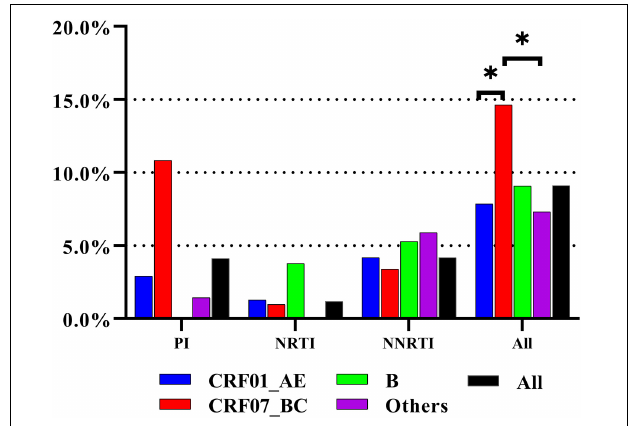
FIGURE 1 | The prevalence of TDR to three class of antiretroviral drugs in different subtypes. The prevalence of TDR was highest in CRF07_BC. * represents statistically